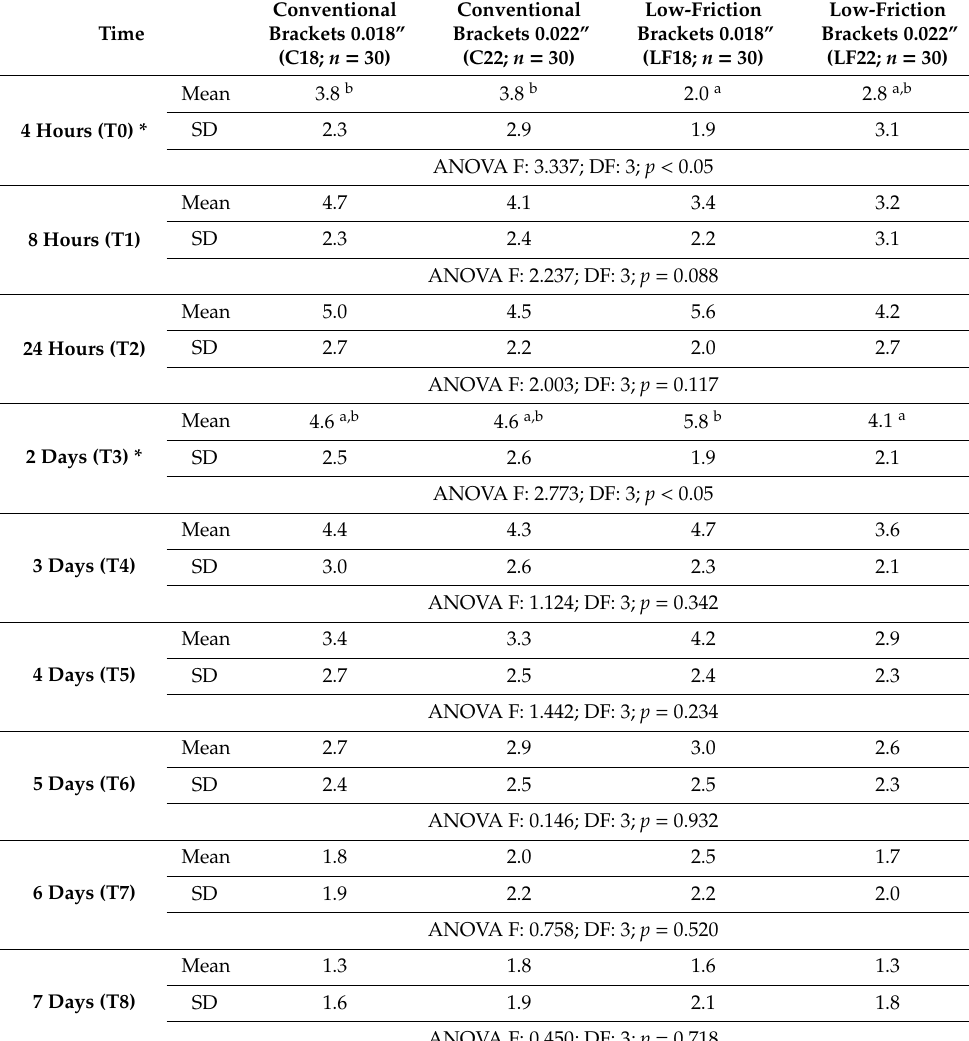
Table 2. Comparison between groups concerning to visual analogue scale (VAS) measurements at di ff erent times. ( n =